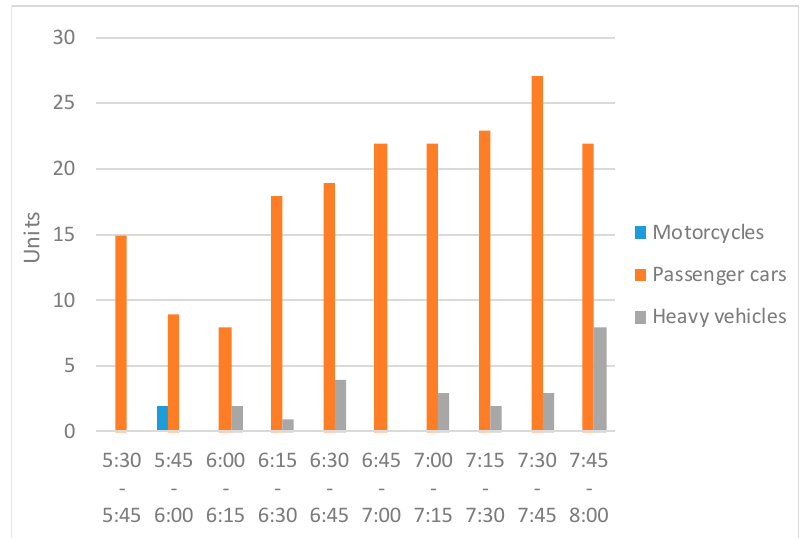
Figure 3. Vehicles in direction A.